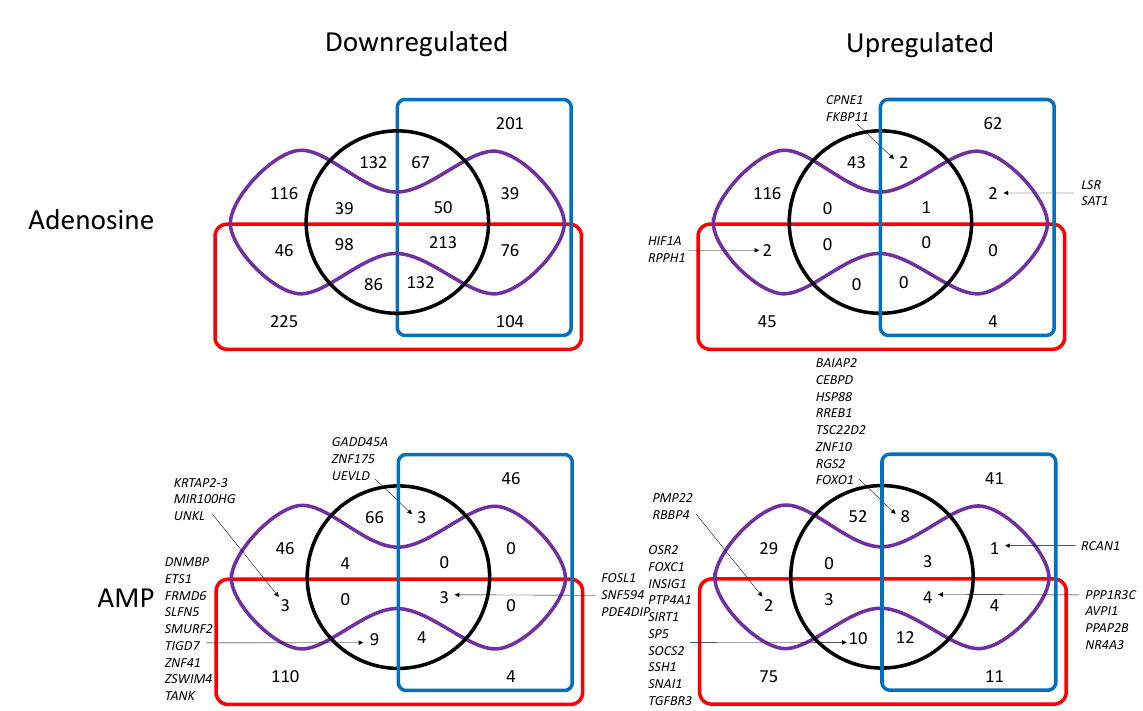
Figure 3. Venn diagram showing the number of at least 2-fold down- ( left ) or upregulated ( right ) transcripts ( p < 0.05) in cells exposed to adenosine (upper panel) or AMP (lower panel) as compared to unexposed cells. Black circle: cN-II + /CD73 + ; red rectangle: cN-II − /CD73 + ; blue rectangle: cN-II + /CD73 − ; purple shape: cN-II − /CD73 − . When the number of transcripts is less than 10 in given groups, the names of transcripts are indicated. Complete list of transcripts is available in Supplementary Tables S4 and S5.